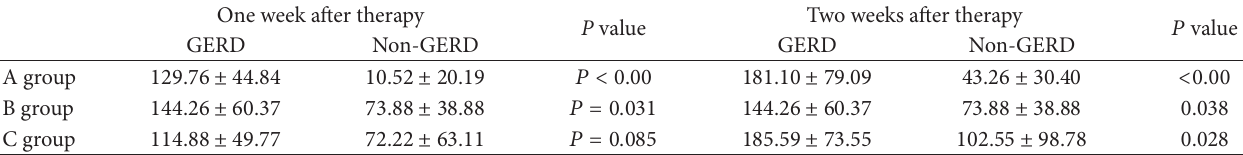
Table 3: Comparison of improving SF-36 scores between GERD and non-GERD patients after one-week and two-week therapy. One week after therapy